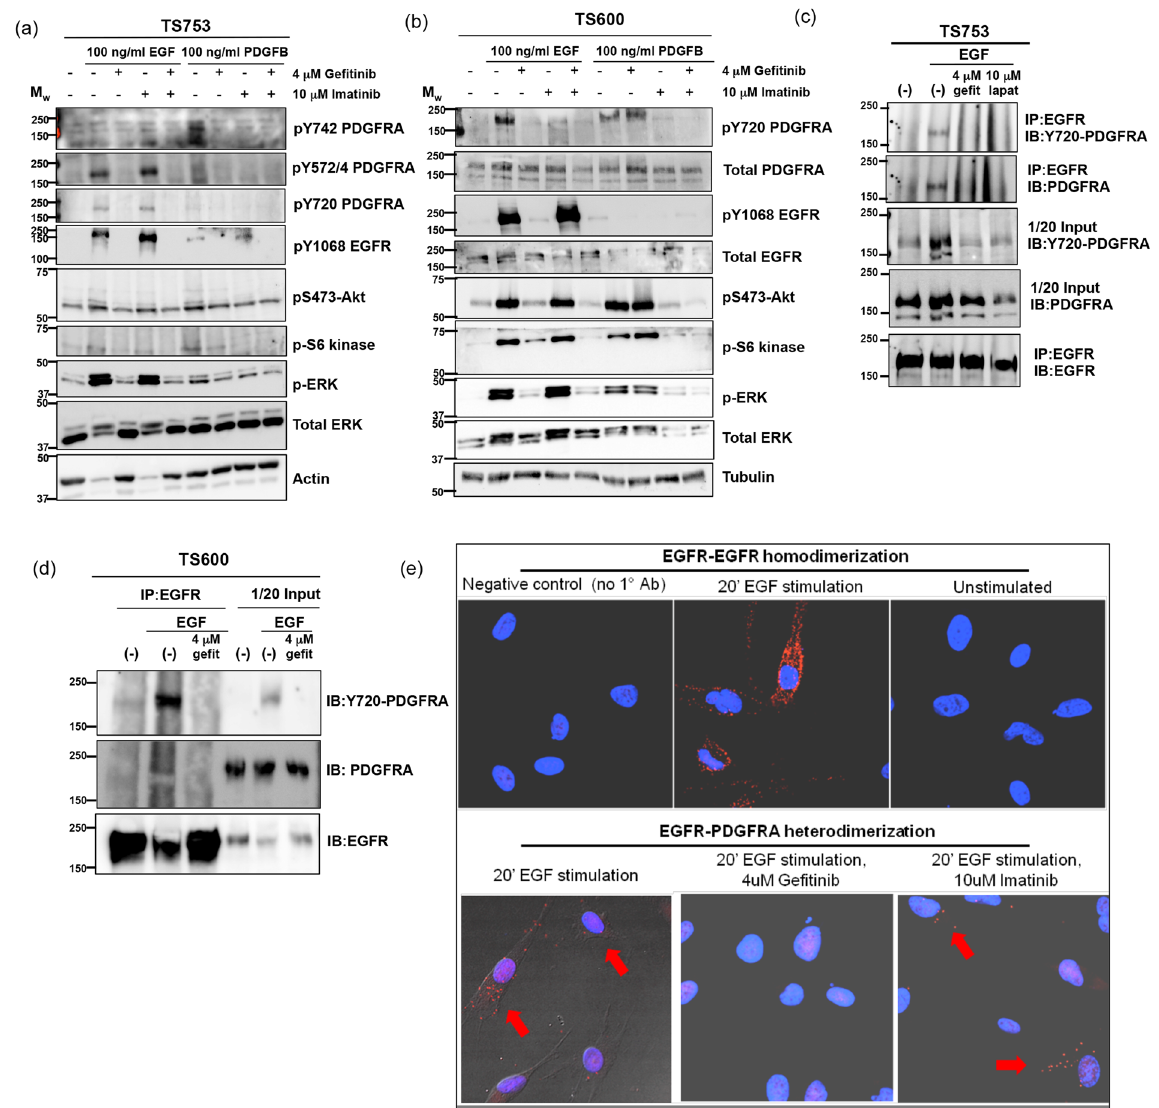
Figure 2. EGF ligand stimulates EGFR-PDGFRA functional transactivation and heterodimerization in glioblastoma lines of varied genotype. Tumorsphere lines of indicated genotypes were serum-starved overnight followed by next-day treatment for 4 hours with the specified RTK-inhibitors. Cells were then ligand stimulated (as indicated) for 20 minutes. Whole cell lysate were collected and 30 micrograms of protein was run on SDS- PAGE and analyzed by western blot with the indicated antibodies. EGF stimulates PDGFRA phosphorylation, which is reversed by gefitinib and, to a lesser extent, PDGFB elicits detectable phosphorylation of EGFR in all lines: ( a ) TS753 – EGFR and PDGFRA focal co-amplification and ( b ) TS600 – EGFR focal amplification and Chromosome 7 gain (also refer to Supplementary Fig. S2). ( c , d ) GTS-lines were serum starved overnight, treated for 4 hours with the indicated inhibitors and then stimulated for 20 minutes with 100 ng/ml EGF. Cells were subsequently lysed and 2 mg of whole cell lysate were immunoprecipitated with total-EGFR antibody overnight. Beads were washed with lysis buffer, heat-denatured, run on SDS-PAGE and probed with activated and/or total PDGFRA antibodies in tumorsphere lines ( c ) TS753, and ( d ) TS600. EGF induced co-immunoprecipitation of EGFR with activated PDGFRA (pY720) in TS753, TS600. Coimmunoprecipitation between EGFR and PDGFRA was reversed by gefitinib and, for TS753, lapatinib as well. Reverse IP with PDGFRA antibody was less efficient but also demonstrated EGFR co-IP reversed by gefitinib (Supplementary Fig. 3a). Coimmunoprecipitation between EGFR and activated PDGFRA (pY720) was also observed in EGFR-vIII positive TS12017 (Supplementary Fig. 3b). ( e ) In situ Proximity Ligation Assay using proximity probes against EGFR and PDGFRA was performed in co-amplified tumor sphere line TS753. Eight-chamber slides seeded TS753 cells were serum starved overnight followed by 4-hour treatment with the indicated inhibitors. Cells were stimulated with EGF for 20-minutes. Cells were counter stained with DAPI (blue) to visualize the nucleus and red-dots show fluorophore expression due to proximity of oligo-tagged EGFR and PDGFRA antibodies associated with EGFR and PDGFRA interaction. Treatment of cells with gefitinib resulted in loss of the EGFR/PDGFRA interaction and thus a loss of in situ PLA signals (red dots), but treatment with imatinib did